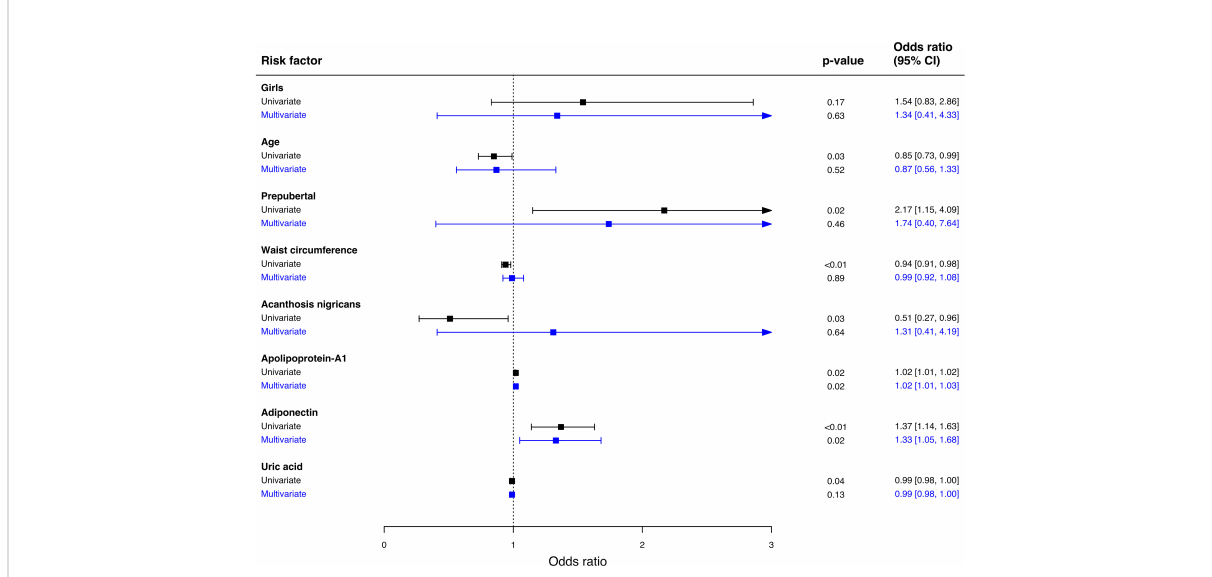
FIGURE 2 Predictors associated with MHO phenotype. Multivariate logistic regression was used to analyze the association between variables and MHO phenotype. Hosmer Lemeshow Test (chi-square = 5.32, p-value = 0.72), classi fi cation table, overall correctly classi fi ed percentage = 80.4. 95% CI; 95% con fi dence